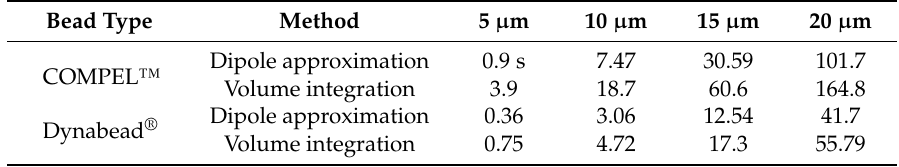
Table 2. Comparison of the dipole approximation method to the volume integration method with respect to time taken for an SPB to travel to an edge of a loop from distances of 5, 10, 15 and 20 µ m. Bead Type Method 5 µ m 10 µ m 15 µ m 20 µ m Dipole approximation 0.9 s 7.47 COMPEL™ Volume integration 3.9 Dynabead ® Dipole approximation COMPEL ™ Dipole